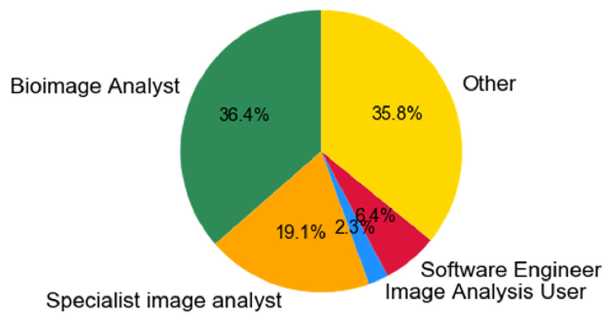
Figure 4. Pie chart representing answers from Q1.4. Participants were able to select multiple answers.